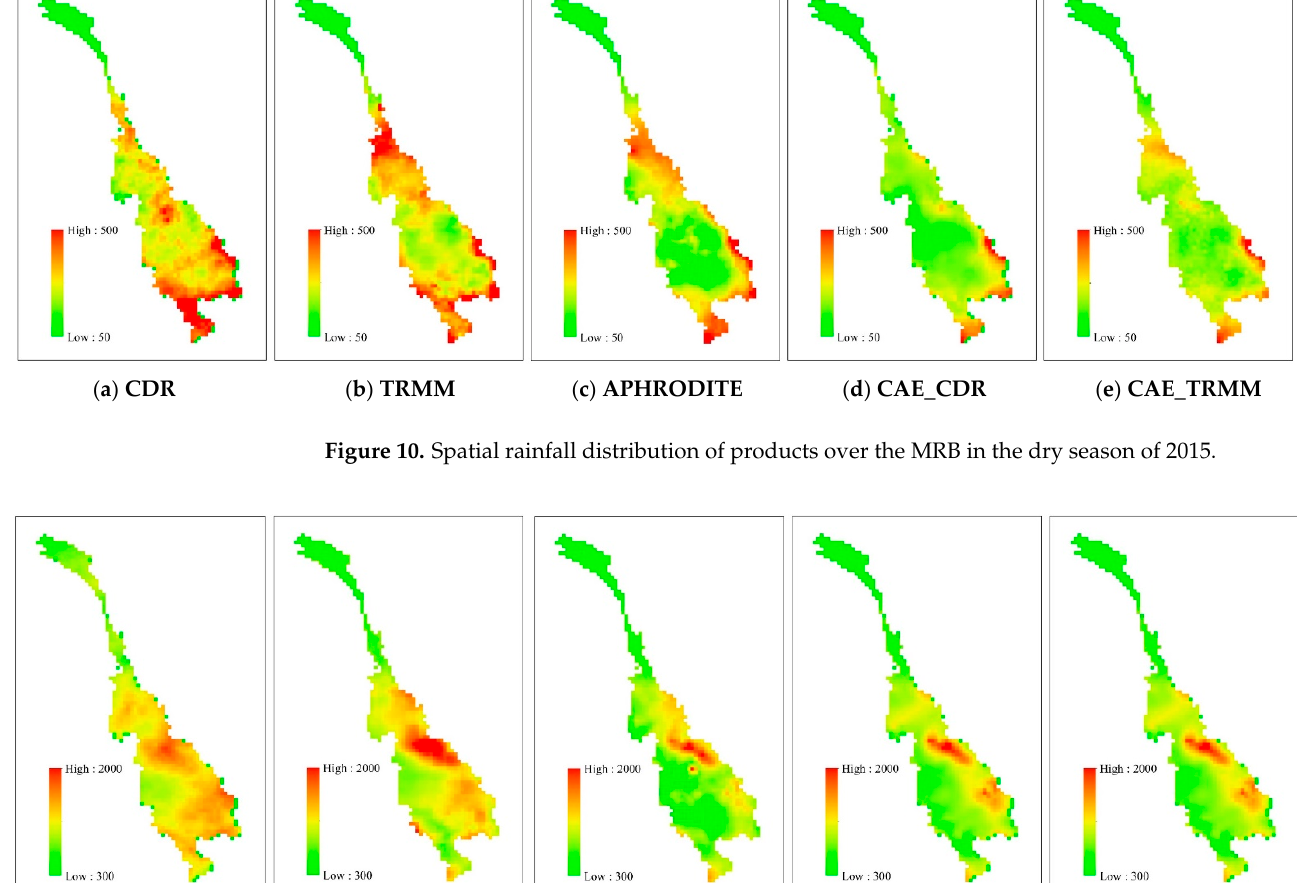
Figure 9. Spatial rainfall distribution of products over the MRB in the wet season of 2014.